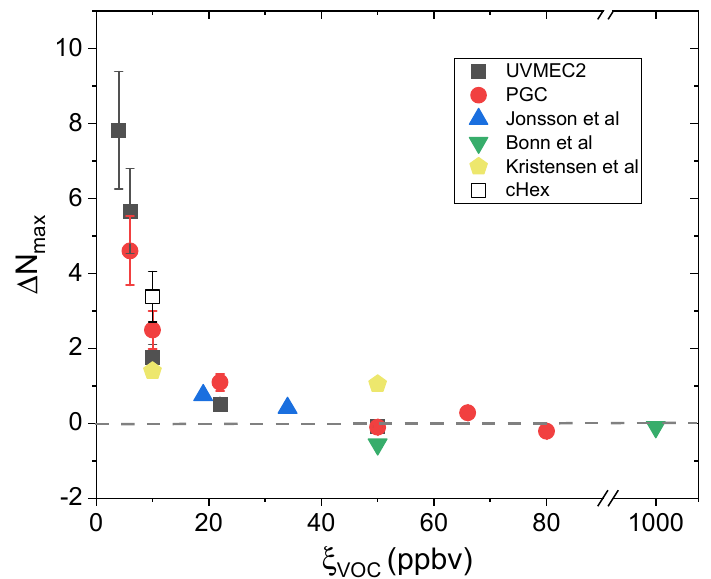
Figure 3. Change in maximum number of particles formed by ozonolysis of α -pinene at different ξ VOC . N 60 and N 0 are the maximum number of particles formed at RH = 60% and 0%, respectively. Δ N = − 1 for the case of complete shutdown of NPF and Δ N = 0 for no change. Dashed line